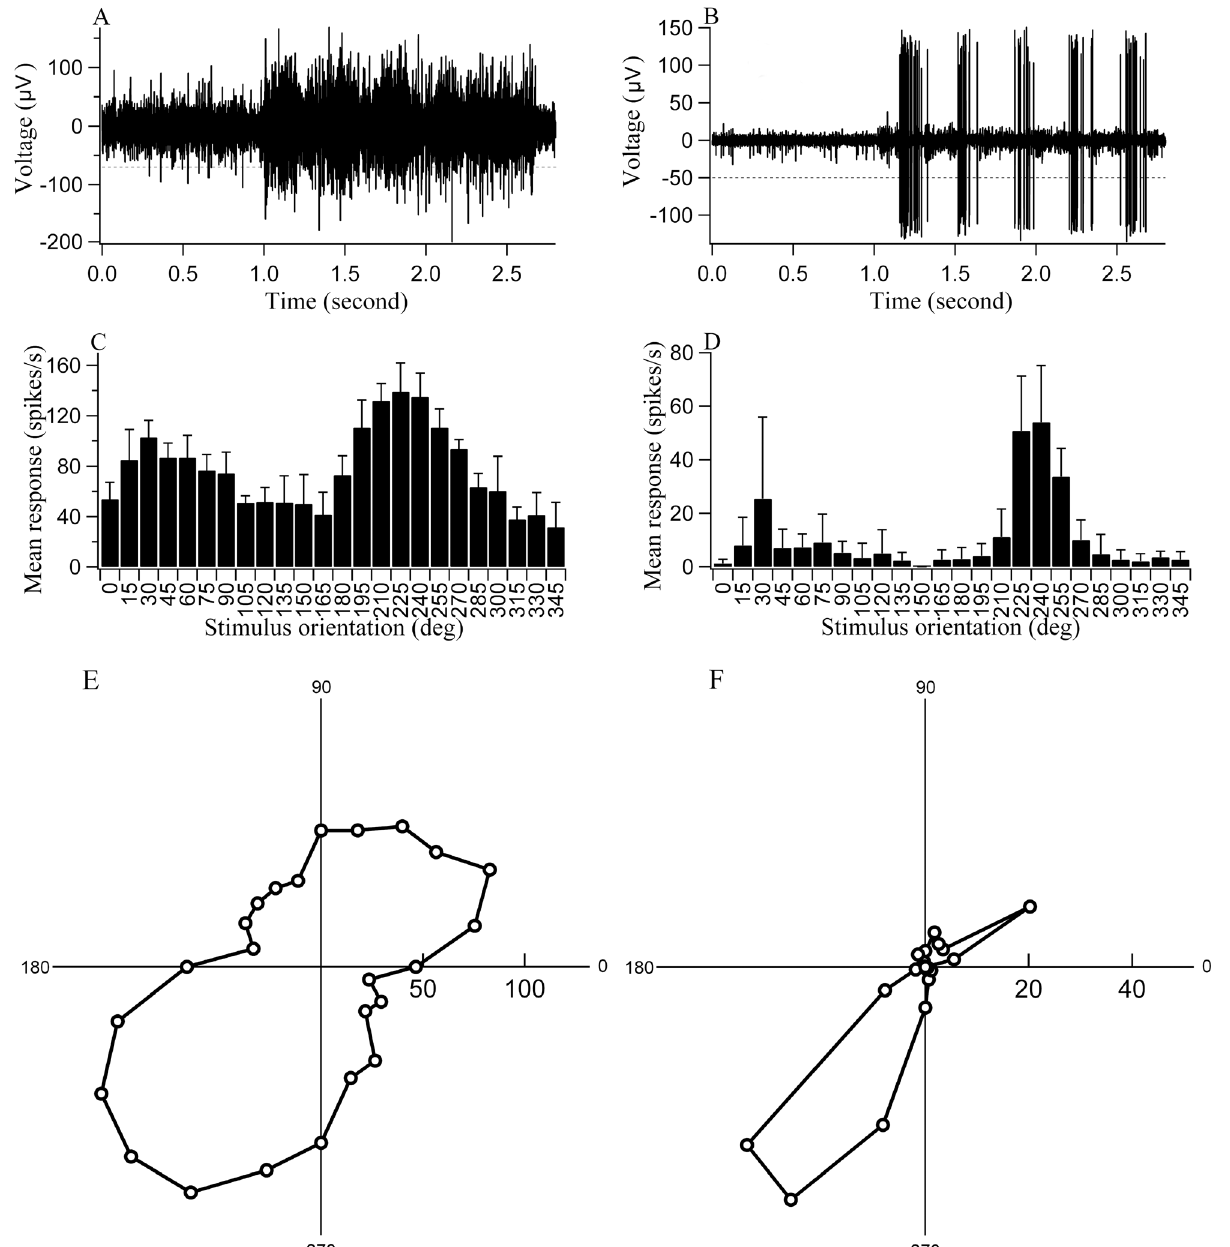
Fig 1. The response property of two typical neurons from the normal control (A, C, E) and DR (B, D, F) group of cats respectively. (A&B) The voltage trace of the neuron ’ s response to its preferred stimulus orientation and motion direction. A spike with amplitude above the horizontal broken line was counted as an action potential. Spontaneous activity was acquired during 1s pre-stimulus period. The neuron ’ s visually-driven response was evoked by 5 cycles of drifting grating stimulus with the preferred orientation, equivalent to a stimulus duration of 1.7s. (C&D) Mean response (pole with error bar) of the neuron to different stimulus orientations. The maximum response represented the neuron ’ s response to the preferred stimulus orientation and motion direction. (E&F) Circle variance showed the neuron ’ s response selectivity for stimulus orientations and motion directions, with orientation bias (OB) of 0.275 and 0.747 respectively, motion direction bias (DR) of 0.133 and 0.487